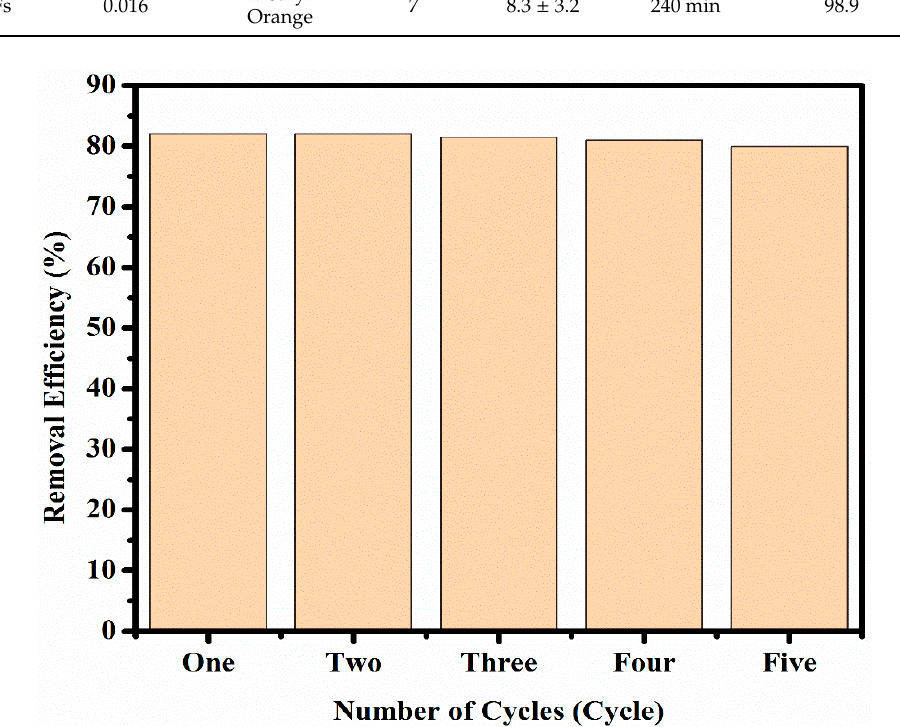
Figure 8. The removal efficiency of Pd/CNF as catalysts for MO degradation remained stable (about 83%) throughout five consecutive cycles of filtration and reuse (after 3 h).